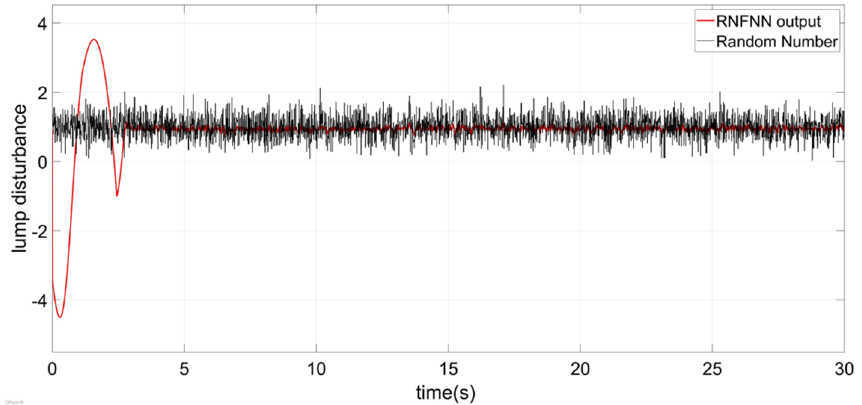
Figure 9. The output of the roll angle RBFNN. The red line is the output of RBFNN, which could approximate the random lumped disturbance with a mean value of 1.